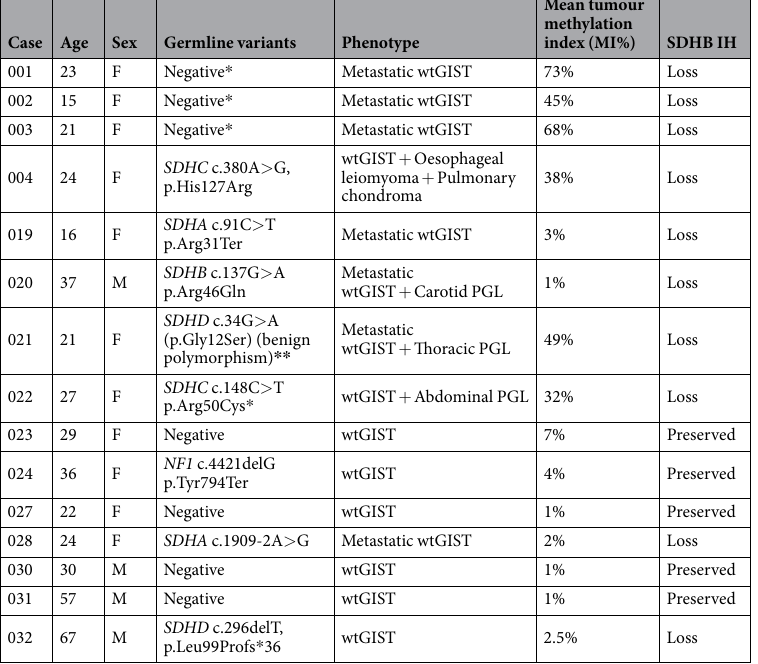
Table 1. Clinical and molecular profile of wtGIST. * MLPA performed. ** Benign polymorphism.